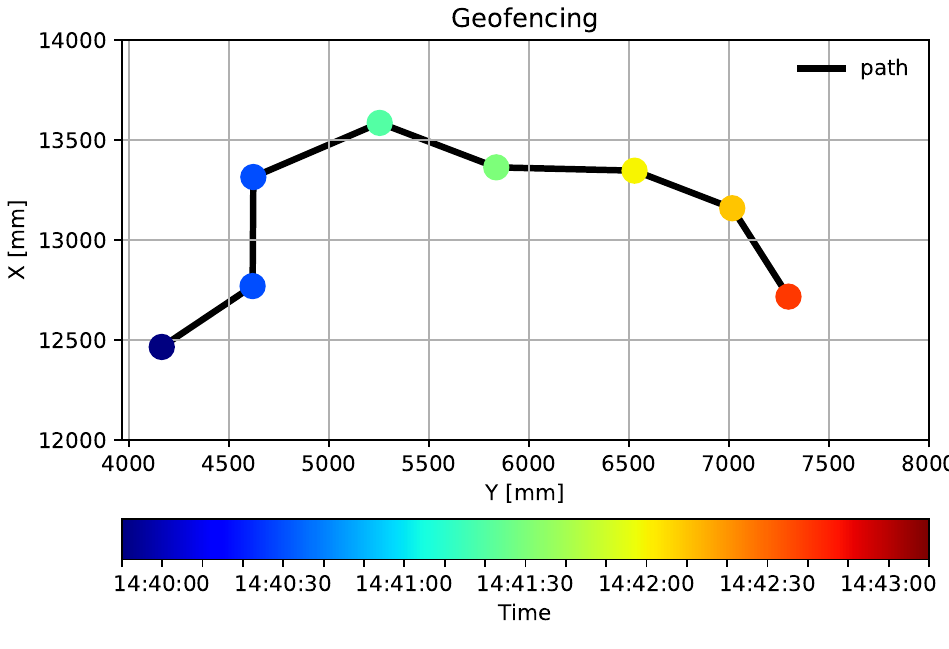
Figure 12. The path of the forklift.